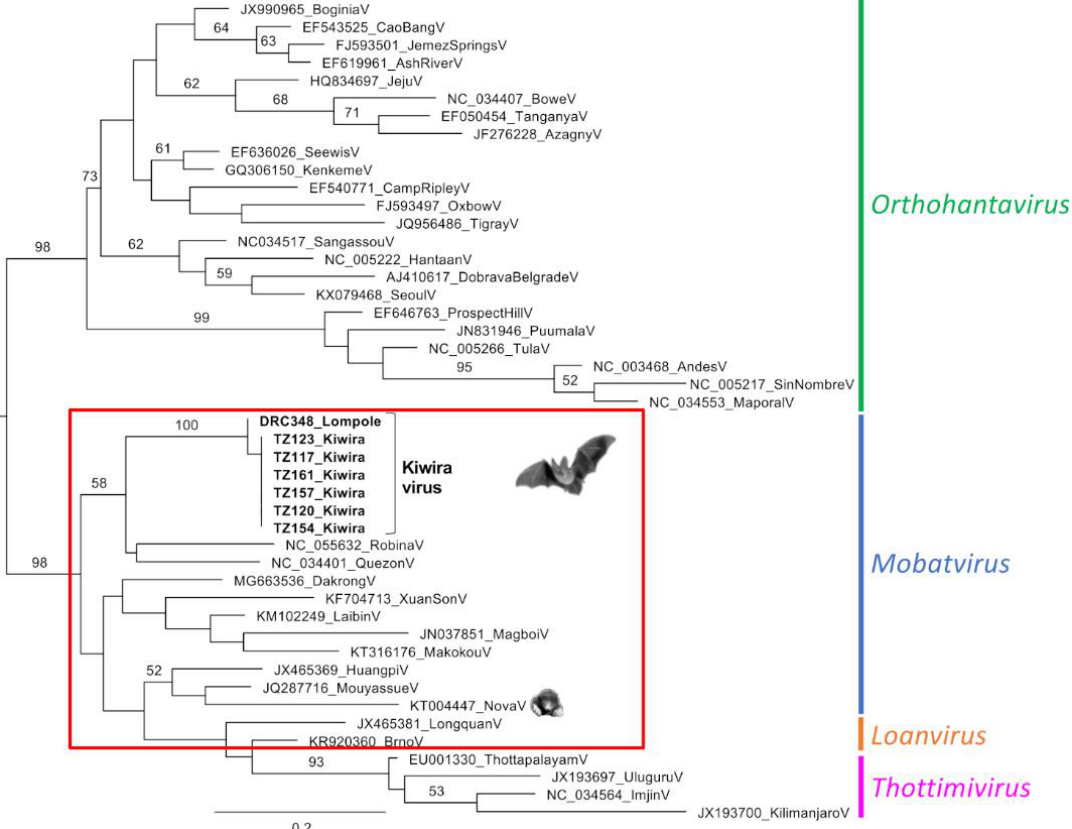
Figure 1. Maximum likelihood phylogenetic tree based on 142 amino acids (aa) of the L segment. Trees were inferred using the LG + G + I model with 1000 bootstraps. Bootstrap values are given in percent and only when above 50%. Viruses from this study are given in bold. Scalebar indicates aa substitutions per site. Table 3. Pairwise identities between sequences from Tanzania and their closest relatives, Quezon virus and Robina virus [%] 1